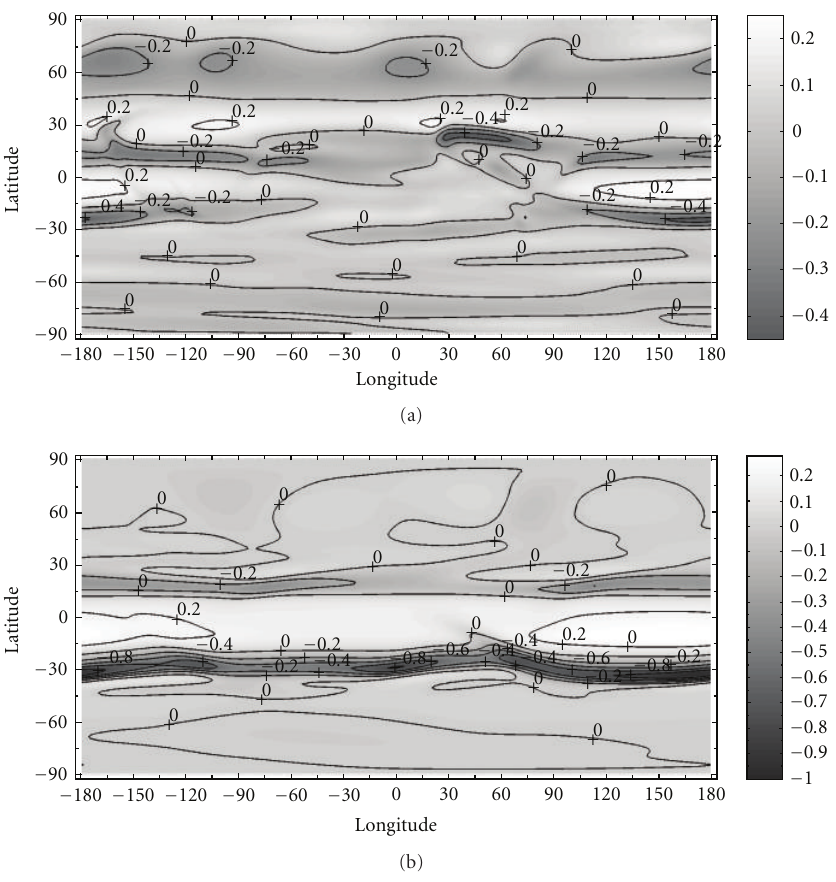
Figure 12: The global distributions of the simulated vertical component of the neutral wind velocity at the altitude of 50 km, obtained for 16 July and calculated for two distinct values of solar activity: F 10 . 7 = 101 (a) and F 10 . 7 = 230 (b). The velocities are given in m/s, with positive direction of the vertical velocity being